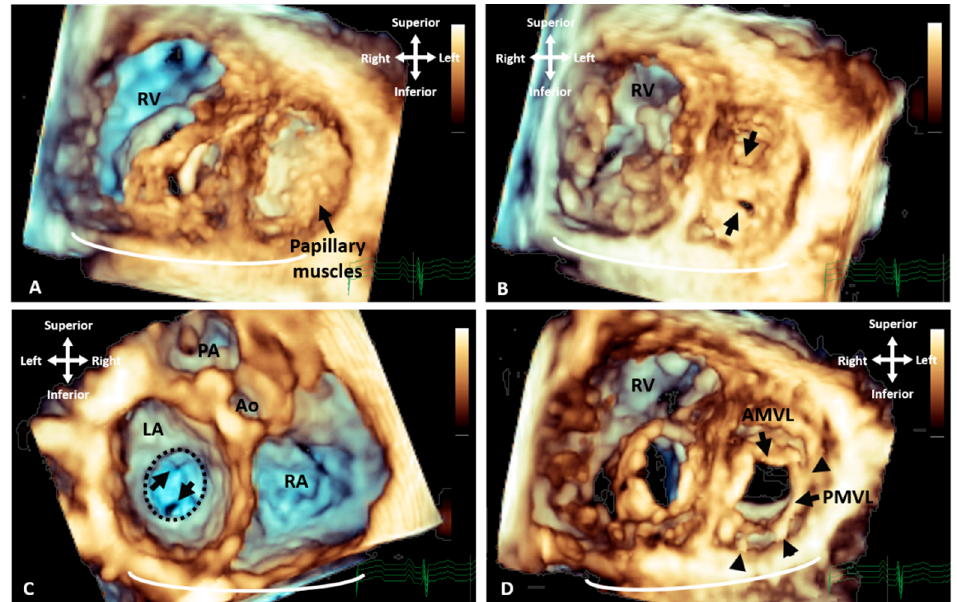
Figure 2. Three-dimensional TTE demonstrating the appearance of parachute mitral valve with complex subvalvar stenosis. ( A ) Demonstrates the thickened and fused subvalvar apparatus with indistinguishable papillary muscles and chords as seen from a distal ventricular view. A view through the middle of subvalvar tissue reveals two small orifices as seen from the ( B ) ventricular and ( C ) atrial aspects, the atrial view also shows the small annulus that is highlighted with the dashed line. ( D ) A view at the level of the mitral valve leaflets shows that although the posterior leaflet is tethered with multiple short chords (arrowheads), the anterior leaflet retains adequate excursion, with area of narrowing and stenosis being within the subvalvar tissue. Ao: Aorta; AMVL: Anterior mitral valve leaflet; LA: Left atrium; PA: Pulmonary valve; PMVL: Posterior mitral valve leaflet and RA: Right atrium.